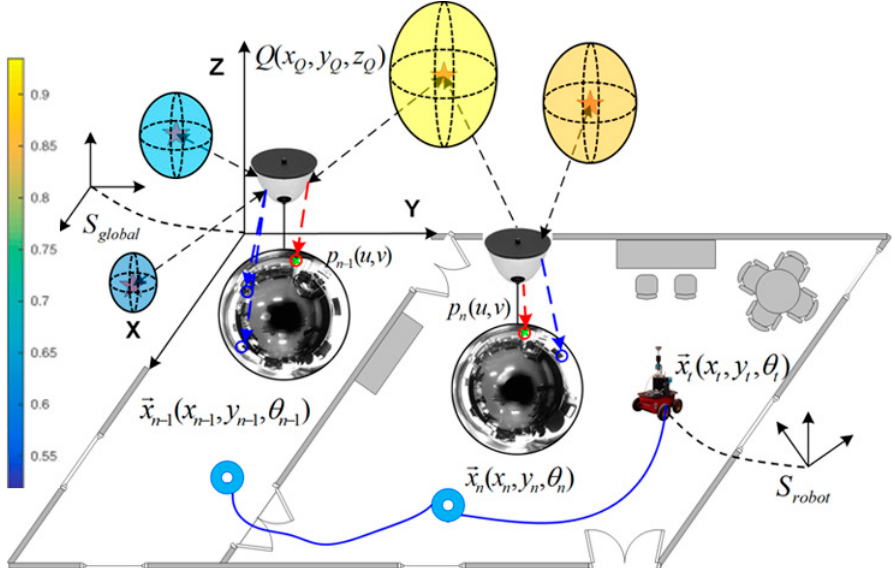
Figure 5. Robot navigation example in an office-like scenario along three poses: (cid:126) x n − 1 , (cid:126) x n , and (cid:126) x t . The 3D probability distribution of feature points’ existence permits associating visual feature points with a specific probability, indicated with colored spheres, whose probability values are encoded according to the left-side colorbar. Projections of a 3D point Q ( x Q , y Q , z Q ) , p n − 1 ( u , v ) and p n ( u , v ) , are also indicated. The 3D global reference system is denoted as S global , and the 3D robot reference system as S robot .